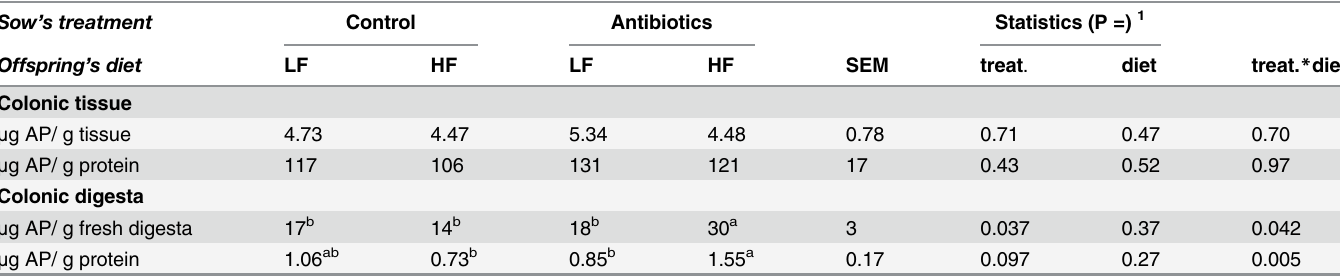
Table 3. Alkaline phosphatase (AP) activity concentrations in colonic tissue and digesta contents of pigs born to control or antibiotic-treated sows and fed a low (LF) or a high (HF) fat diet between 140 and 169 days of age (LSmeans and SEM, n = 10 per treatment). Sow ’ s